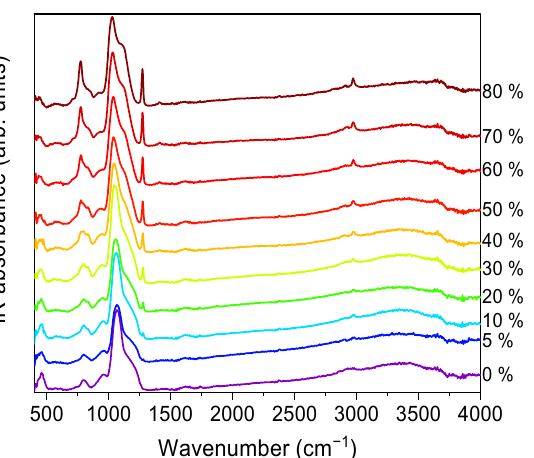
Figure 6. FTIR spectra of series A at different methyl concentrations. All spectra have been vertically shifted (series A represents the pH = 2.0).